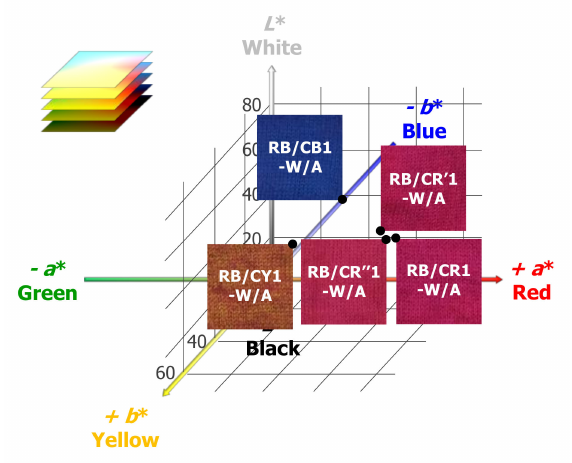
Figure 3. Photographic images of RB / CY1-W / A, RB / CB1-W / A, RB / CR1-W / A, RB / CR (cid:48) 1-W / A, RB / CR”1-W / A and their corresponding coordinate positions in CIELab color